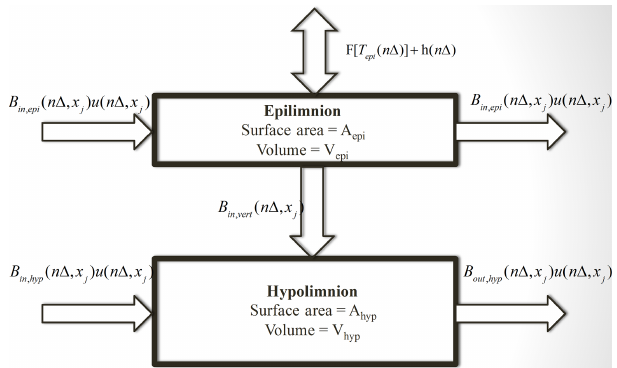
Figure 2. Conceptual model of a continuously stirred reactor (CSTR) for the two-layer reservoir